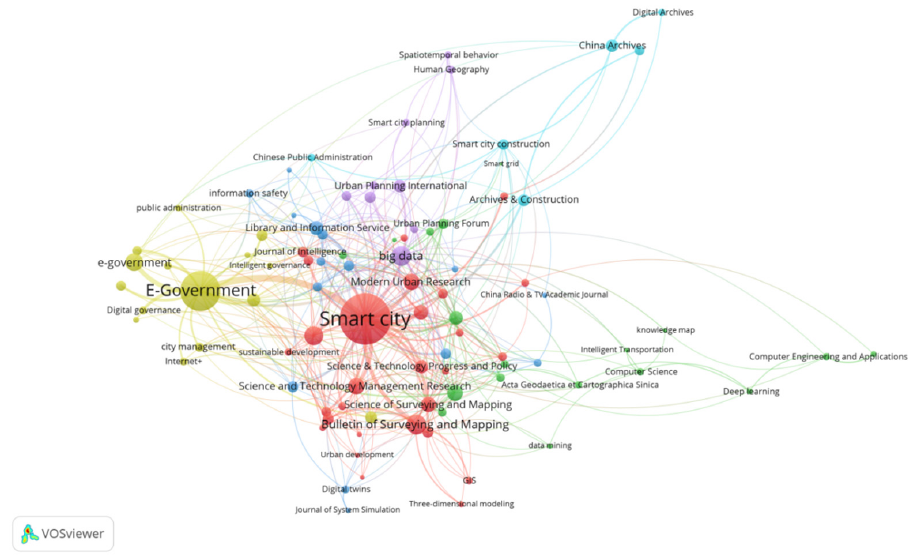
Figure 4. Co-occurrence map of journals and keywords.